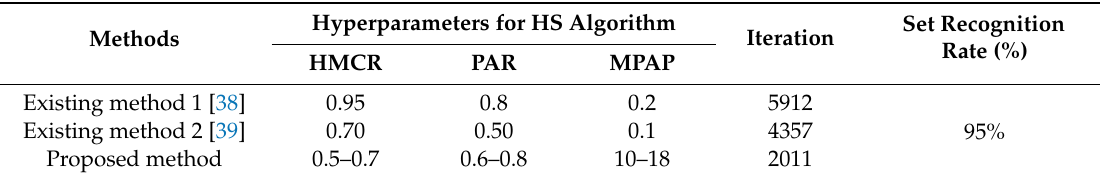
Table 5. Number of iterations required to reach 95% recognition rate for each hyperparameter combination to find appropriate hyperparameter value for HS